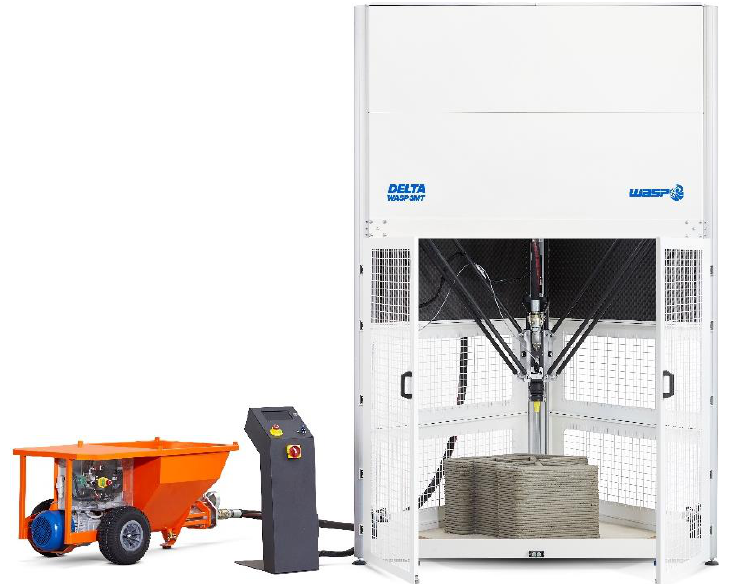
Figure 2. The Delta WASP 3MT Industrial 4.0 LDM (https://www.3dwasp.com/en/concrete-3d- printer-delta-wasp-3mt-concrete, accessed on 20 December